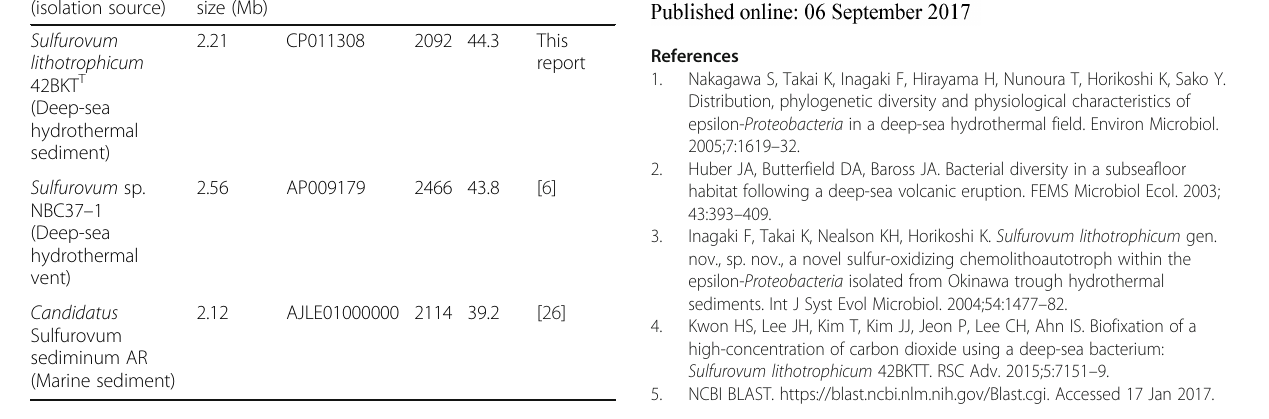
Table 5 Species in the genus Sulfurovum Species (isolation